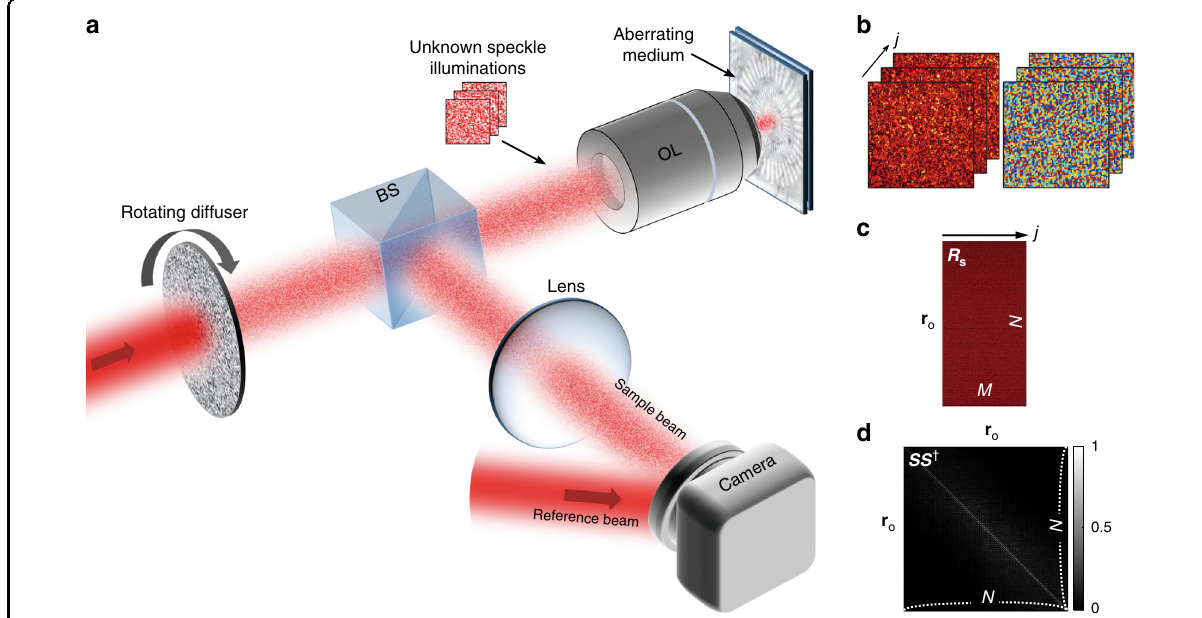
Fig. 2 Experimental setup for recording a compressed time-reversal matrix. a Schematic of the experimental setup. BS: beamsplitter, OL: objective lens. A Ti: Sapphire pulsed laser is used as a low-coherence light source. Random speckle patterns produced by a rotating diffuser illuminate a sample. The off-axis holograms between the sample wave and a plane reference wave are recorded by a camera. Optics for reference beam path is omitted for brevity. b Representative E- fi eld amplitude (left) and phase (right) images of the sample wave. The size of each image is 40 × 40 µm 2 , composed of N = 7744 orthogonal modes. c Sparsely-sampled timed-gated re fl ection matrix R S reconstructed by a set of M = 700 E- fi eld images. d The matrix SS † obtained from an experimentally measured S by placing a mirror at the sample